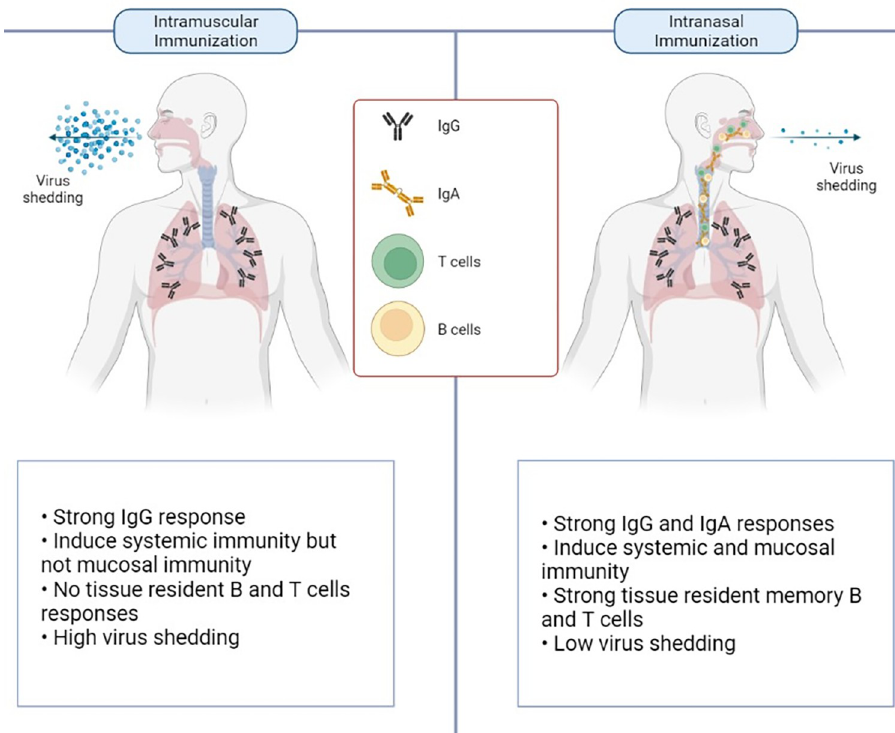
Fig 1. Key differences in immunity following intramuscular and intranasal immunization. This figure is modified from “Scent of a vaccine” in Lund and Randall, 2021 [20].